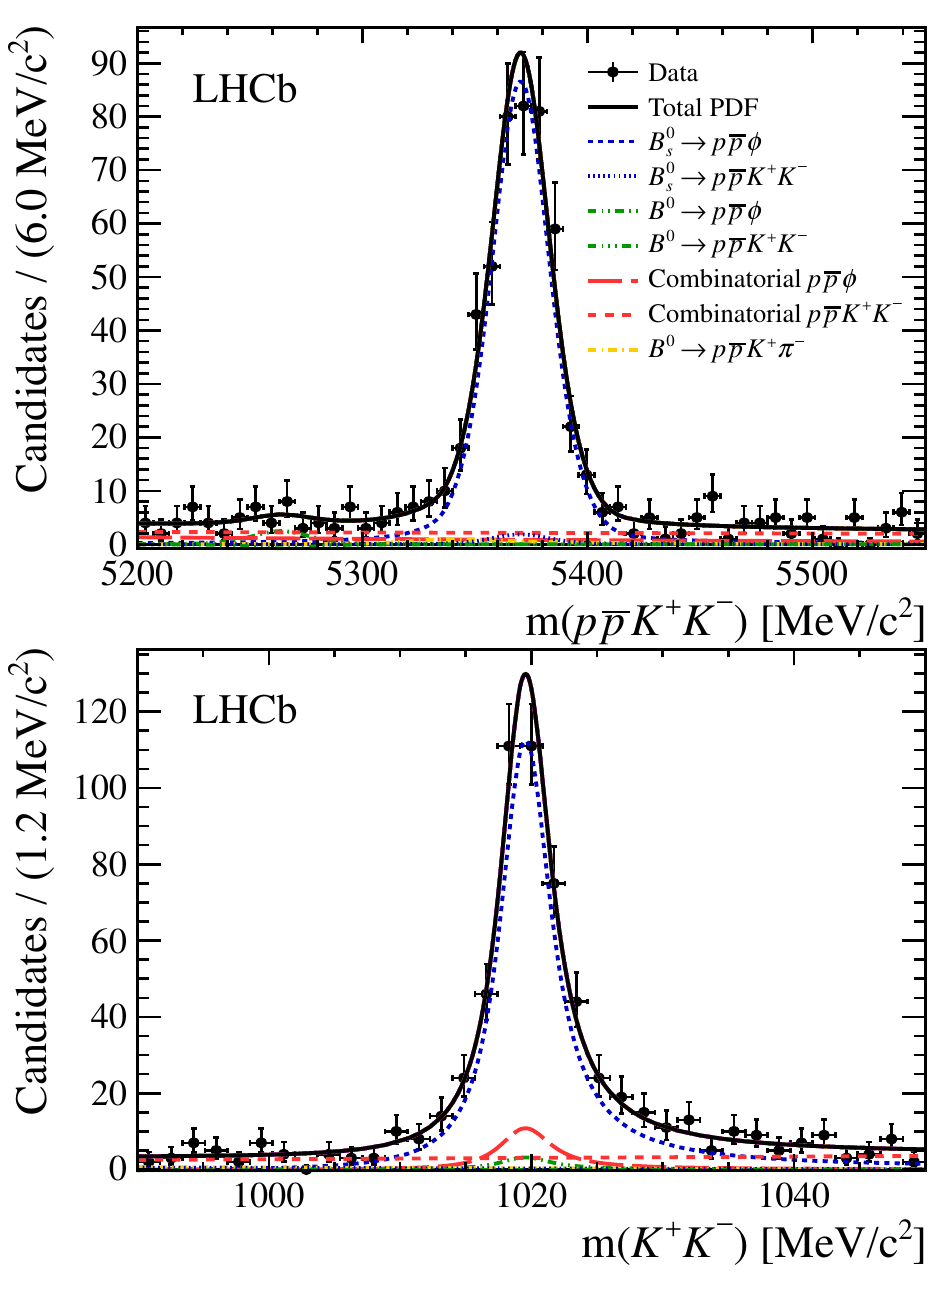
Figure 6 . Distribution of the p (cid:22) pK + K (cid:0) (top) and K + K (cid:0) (bottom) invariant masses. Points with error bars show the data. The solid black curve is the projection of the total (cid:12)t result. The short-dashed and dotted blue curves show the B 0 ! p (cid:22) p(cid:30) and B 0 ! p (cid:22) pK + K (cid:0) contributions, respec- s s tively. The long-dashed and medium-dashed red curves show the contributions of the combinatorial background with prompt (cid:30) and NR K + K (cid:0) , respectively. The dashed-double-dotted green, dashed- triple-dotted green and dashed-single-dotted-yellow curves show the B 0 ! p (cid:22) p(cid:30) , B 0 ! p (cid:22) pK + K (cid:0) and B 0 ! p (cid:22) pK + (cid:25) (cid:0) contributions, respectively.